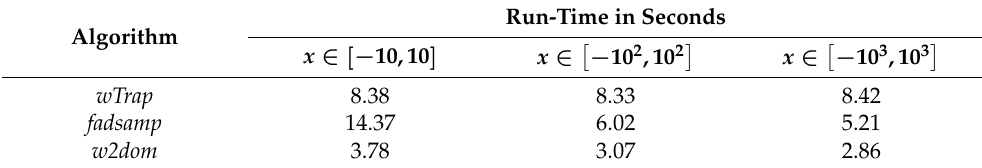
Table 2. Run-time of algorithms for 30 million points at three different